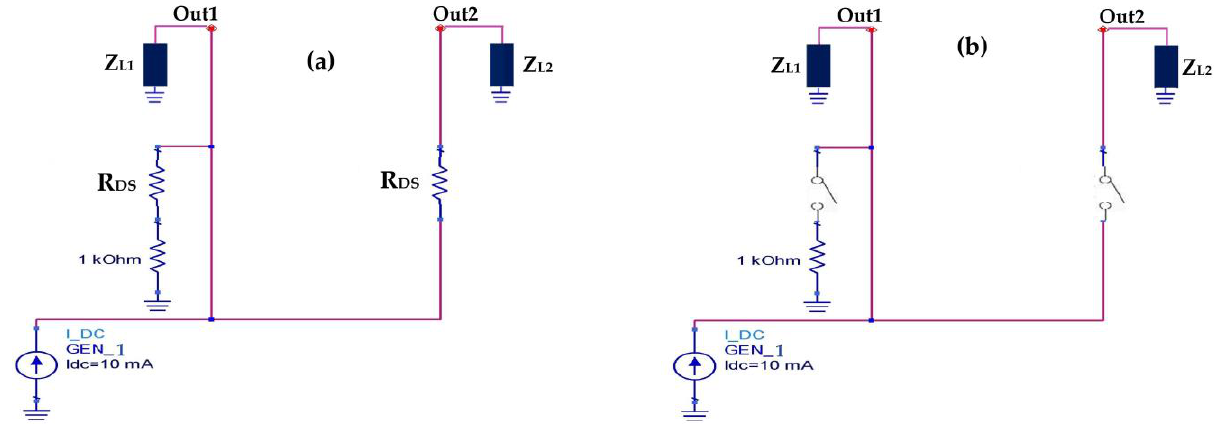
Figure 22. ( a ) Proposed switch circuit, ( b ) Simulated DC output currents (Out1, Out2). Z L1 = 7.2 kΩ, Z L2 = 0.1 Ω .